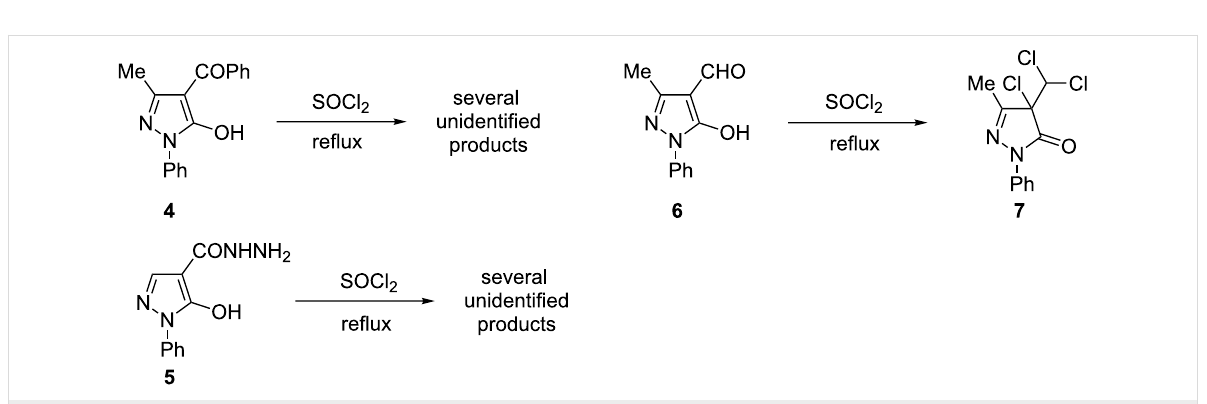
Scheme 4: Reaction of different 5-hydroxypyrazoles with thionyl chloride.